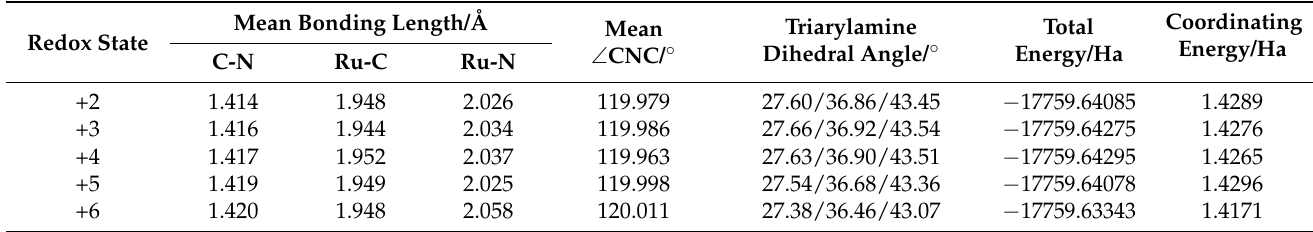
Table 1. Molecular structures and energies of CTTC molecule in various redox